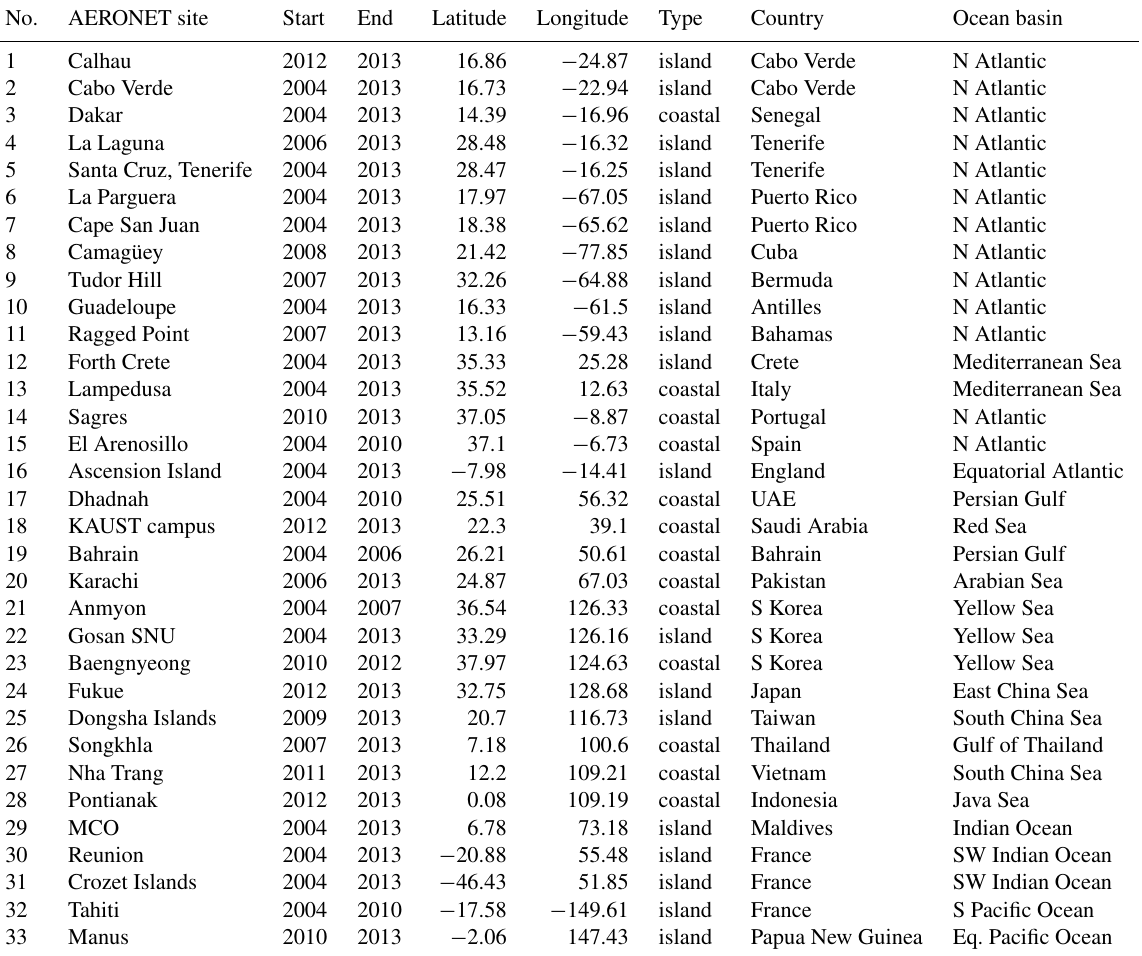
Table A1. List of AERONET sites used in the comparison with OMI retrievals. Table includes information of the start and end years used in the comparison, location (latitude/longitude), type of sites (coastal/island), country and ocean basin.